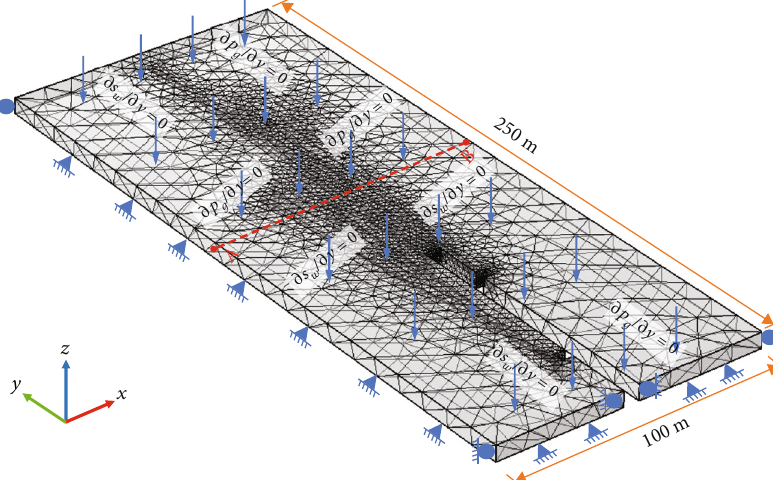
Figure 2: Numerical simulation of physical geometry